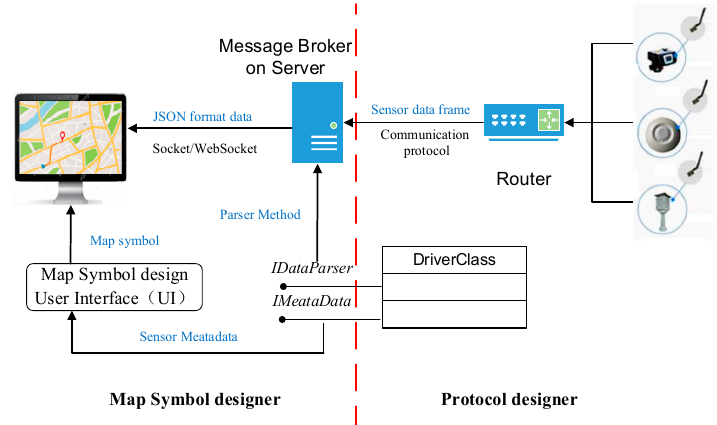
Figure 3. Map symbol construction and real-time visualization process based on protocol parsing interface.